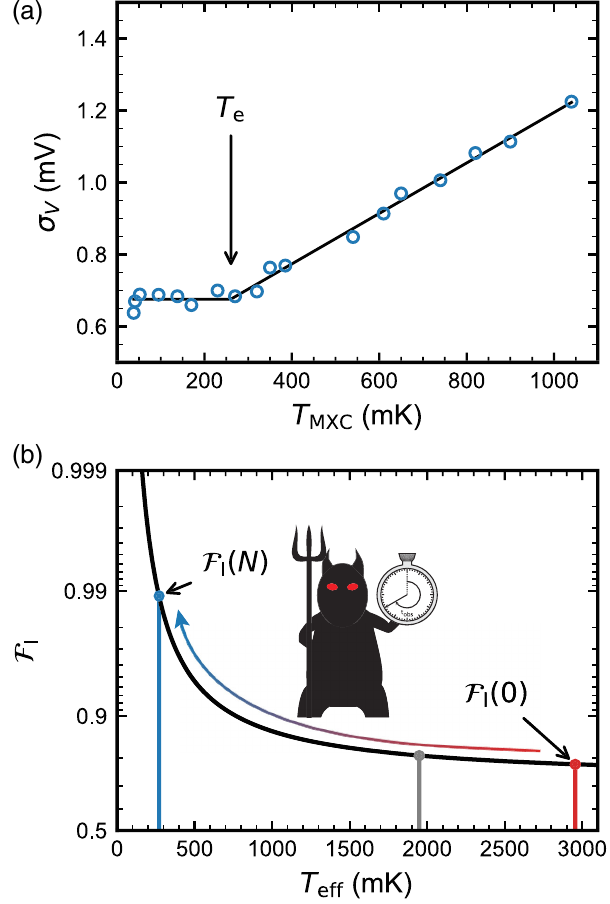
FIG. 6. (a) The electron temperature T e ¼ 260 mK is deter- mined by the onset of an excess thermal broadening σ V of the SET Coulomb peaks when increasing the temperature T of MXC the dilution refrigerator ’ s mixing chamber. (b) The initialization fidelity prior to the Maxwell demon ’ s intervention (shown in red) is F I ð 0 Þ ¼ 78% , which corresponds to the Fermi population at T 2 . 95 K. With Maxwell ’ s demon monitoring, F I reaches eff ¼ approximately 99% (shown in blue), which corresponds to an 270 effective temperature T eff ¼